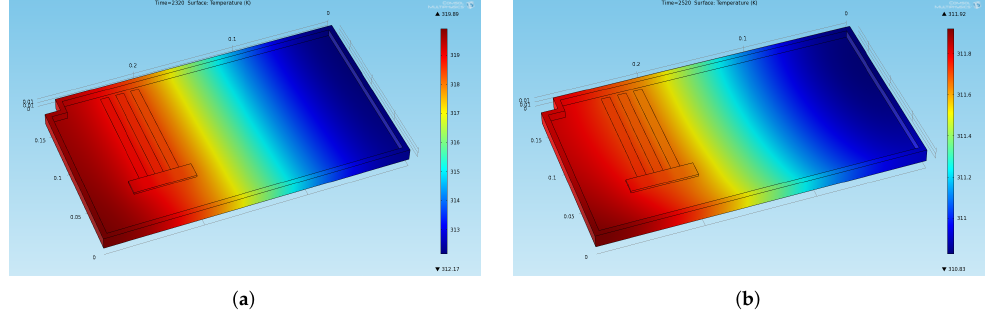
Figure 7. Temperature distribution obtained through the preliminary CFD simulation at two signif- icant instants of time in the stabilized cycles ( a ) End of the last thermal charge phase: t = 2320 s. ( b ) End of the last thermal discharge phase: t = 2520